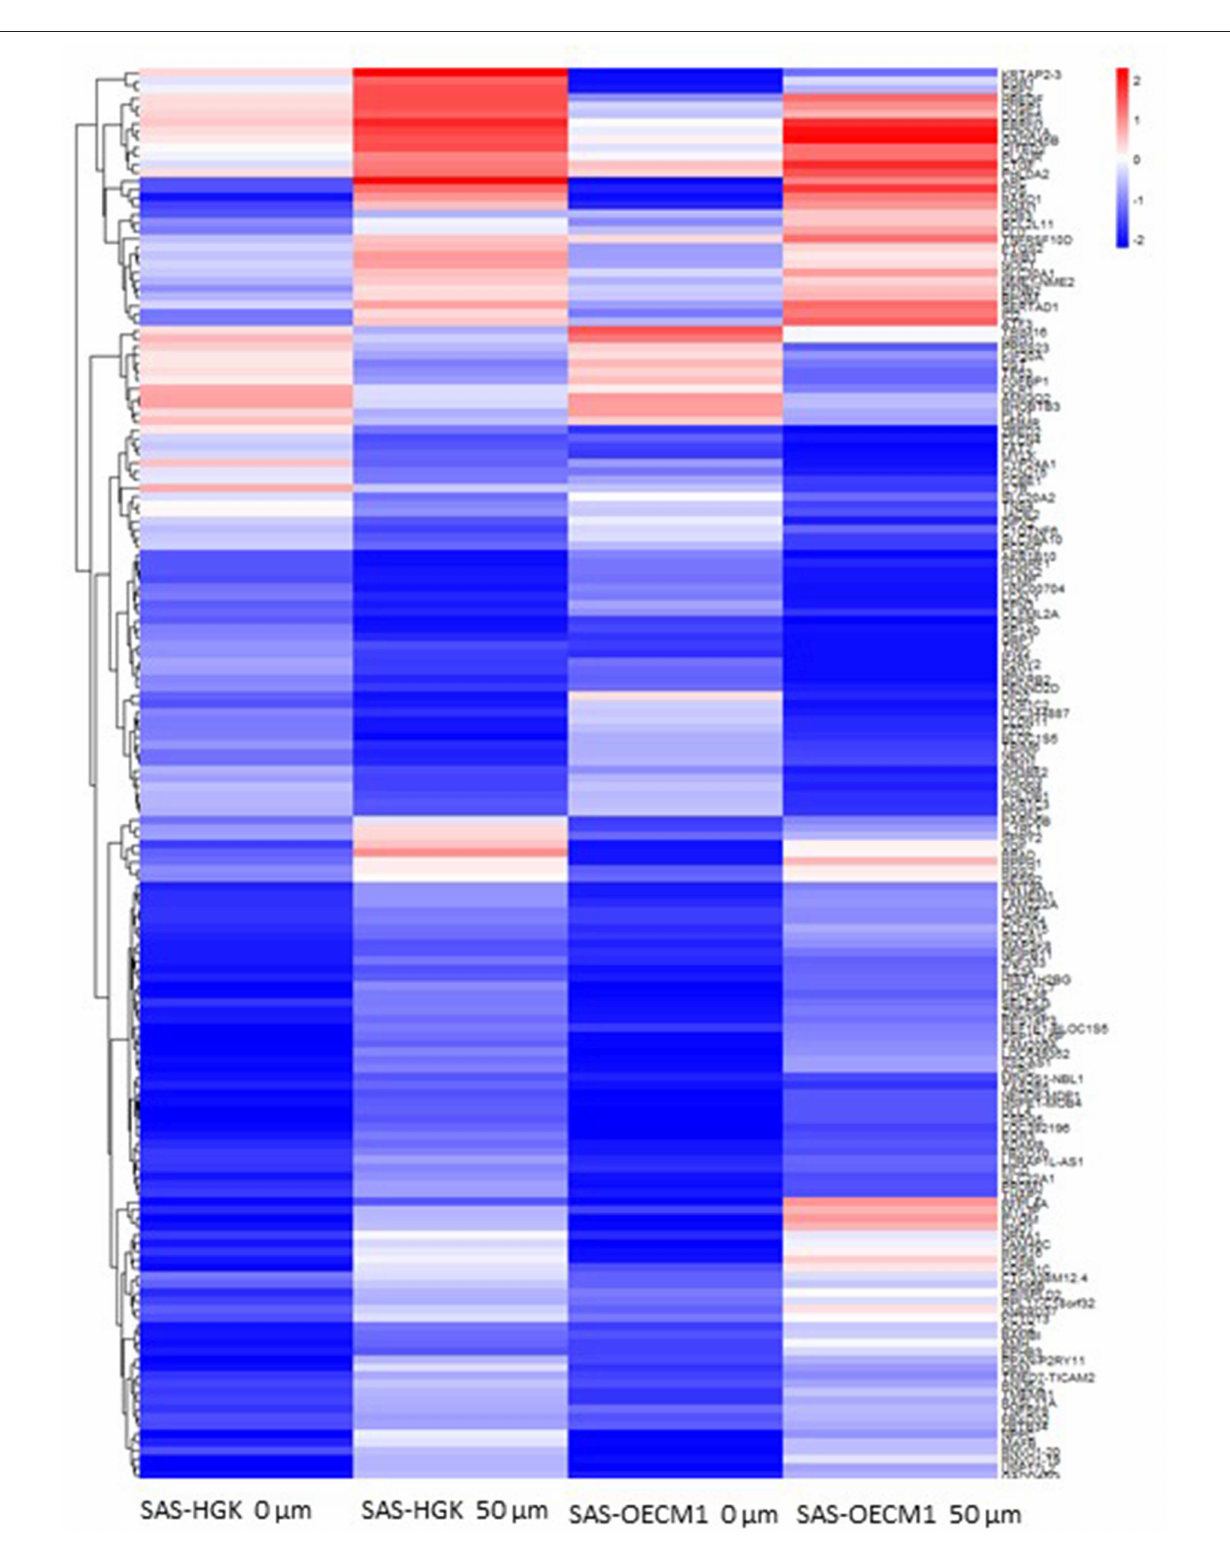
Frontiers in Oncology | www.frontiersin.org